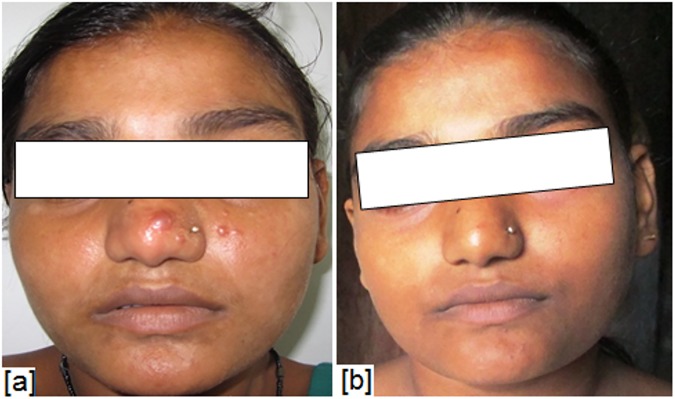
Skin lesions in a female patient- (a) before treatment, (b) after treatment with amphotericin B 0.5mg/kg/day.